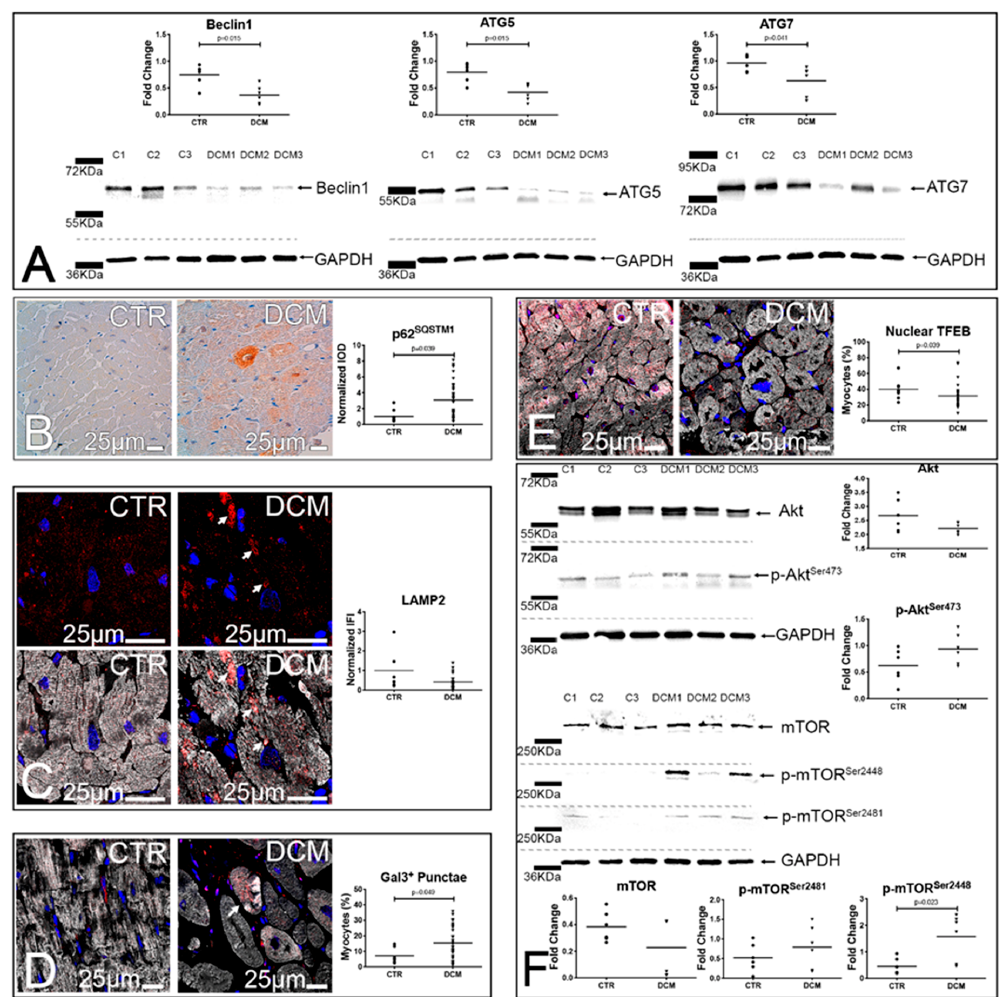
Figure 2. Defects of the autophagy lysosomal pathway characterize the hearts of DCM patients. ( A , B ) Autophagy. Western blots (WBs) of whole protein extracts of 3 control hearts and 3 DCM explanted hearts. Blotted proteins were incubated with antibodies against Beclin 1, Atg5, Atg7, and GAPDH. Densitometric analyses of 6 DCM and 6 controls are shown in dot plots; unpaired t tests (Beclin 1 and Atg 5) and Mann–Whitney tests (Atg 7) were employed ( A ). Microimages of p62 SQSTM1